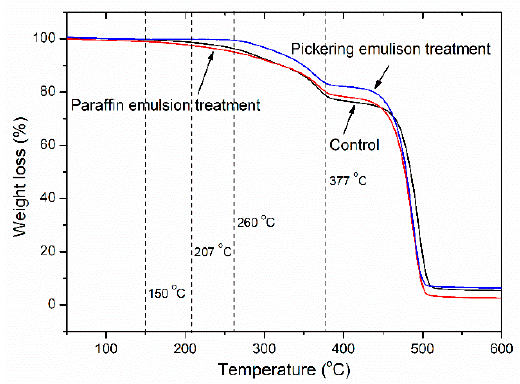
Figure 11. Thermal stability of untreated (control) and emulsion treated WF/HDPE composites.